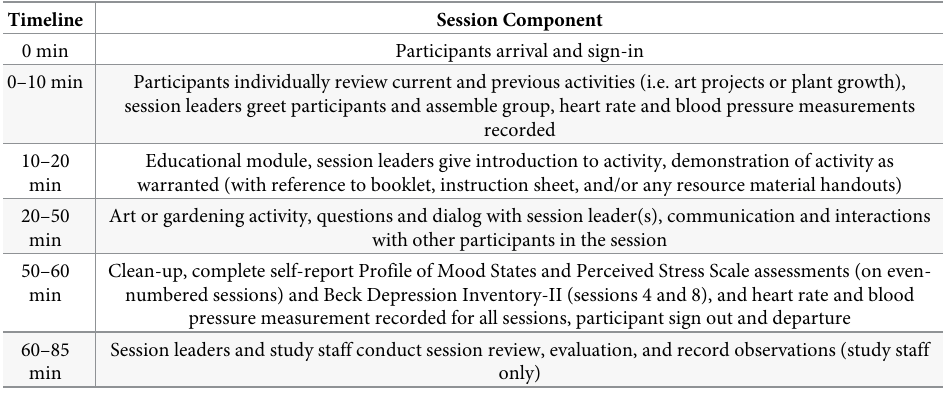
Table 2. Timeline sequence for the eight experimental art and gardening intervention